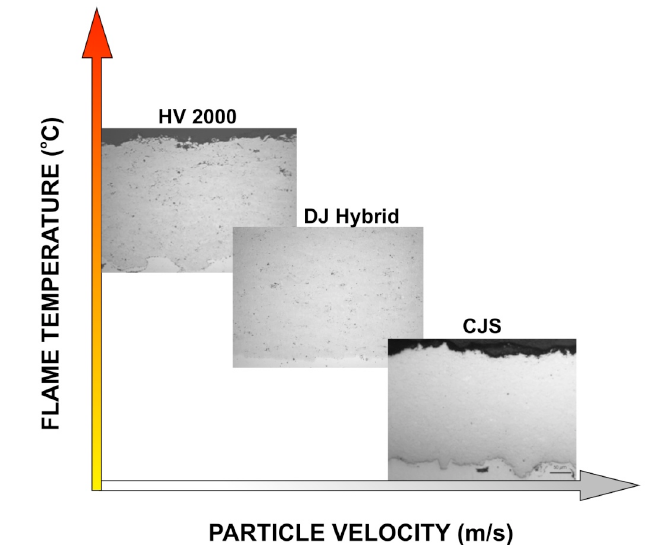
Figure 3. Faster particle velocities and lower particle temperatures in HVOF process have a clear influence on the coating microstructure, where amount of oxidation in the lamella boundary is lowered, the flattening rate increased, and due to this the coating density is